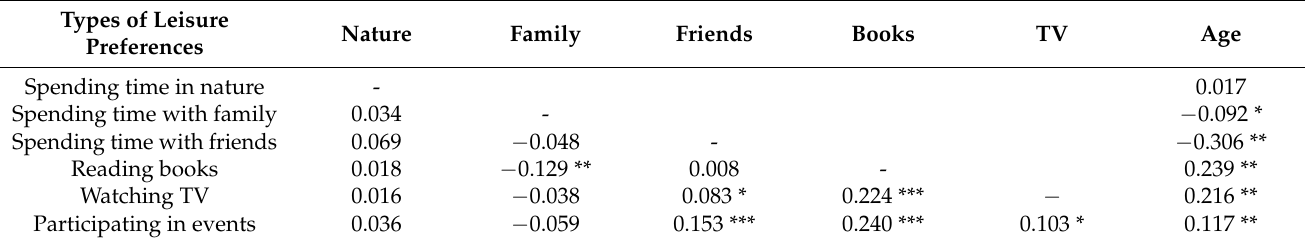
Table 4. Bivariate Spearman’s correlations between the types of leisure preferences and age.